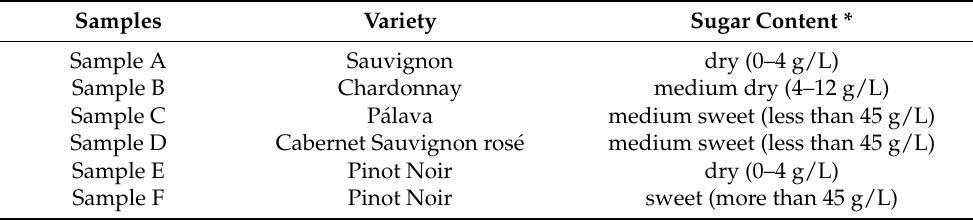
Table 2. Samples’ description, harvest